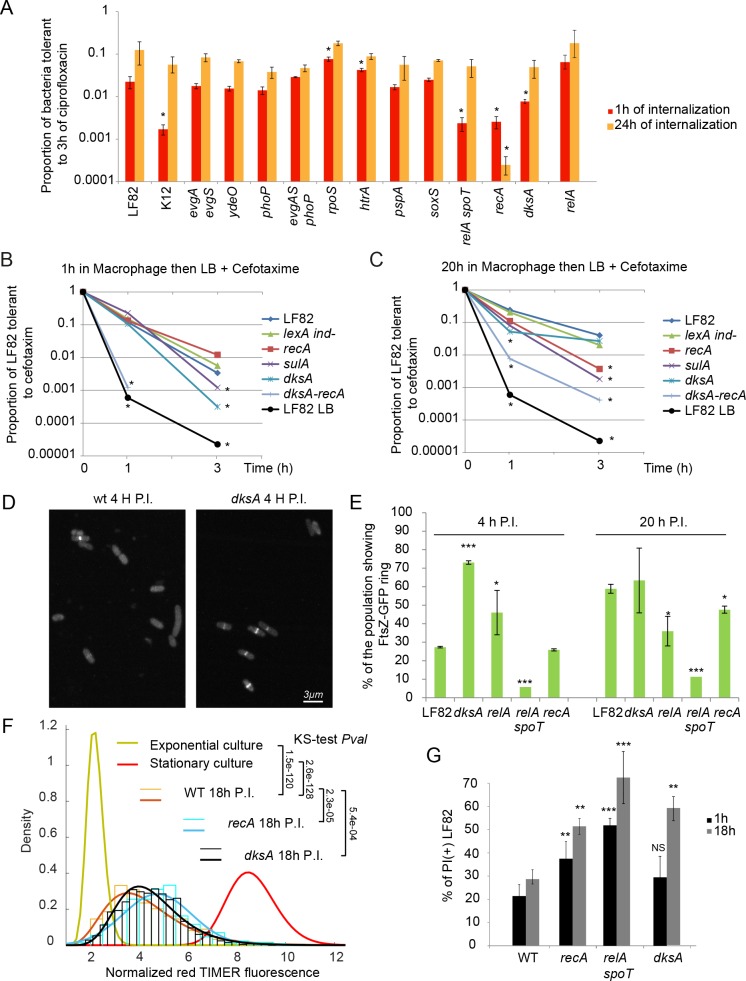
SOS and stringent responses control LF82 cell cycle in the macrophages.A) Proportions of LF82, K12-C600 and LF82 deletion mutants that were tolerant to a 3h ciprofloxacin challenge following a 1 h or 24 h intracellular period within THP1 macrophages. Values represent the average of 3 to 7 experiments. Data were analyzed by using a Student’s t test to determine differences compared with wild-type LF82. *P < 0.05. B) Measure of the proportions of LF82 lexA ind, recA, sulA, dksA, dksA lexAind-, dksA recA mutants that were tolerant to 3 h of cefotaxim challenge after 1 h of macrophage infection. The 3 htime point was below detection limit for the dksA recA mutant because of the poor viability of the mutant in macrophages. Cefotaxime only kills growing bacteria; therefore we resuspended LF82 in LB after macrophage lysis. Under these conditions, we did not observe the plateau observed for persisters to ciprofloxacin, suggesting that tolerant rather than persister bacteria were measured. C) Same as in B but with 20 h of macrophage infection. Values represent the average of 3 to 7 experiments. Data were analyzed using a Student’s t test to determine differences compared with wild-type LF82. *P < 0.05. D) Imaging of FtsZ-GFP ring for the WT and dksA strains after macrophage lysis 4 h P.I. E) Measure of the number of dividing bacteria (presence of an FtsZ-GFP ring at mid-cell) for the WT, dksA, relA, relA-spoT and recA strains after macrophage lysis at 4 h and 20h P.I. N = 3, 300 bacteria were counted for each experiment. Data were analyzed using a Student’s t test to determine differences with the proportion LF82 cells with a FtsZ ring at each time point, *P < 0.05 and *** P<0.0001. F) Distribution of red TIMER fluorescence in exponential and stationary phase culture and 18 h P.I.. The WT and recA and dksA mutants were tested during infection. Data are fitted with normal law (thick lines). Data were analyzed two by two with a Kolmogorov-Smirnov tests. G) Live and dead assay performed 1 h and 18 h P.I., in the LF82, LF82recA, LF82lexAind-, LF82sulA, LF82relAspoT and LF82dksA strains. Data were analyzed using a Student’s t test to determine differences with the proportion of Propidium iodide (+) LF82 at 1 h and 18h post-infection, ** P<0.001 and *** P<0.0001.